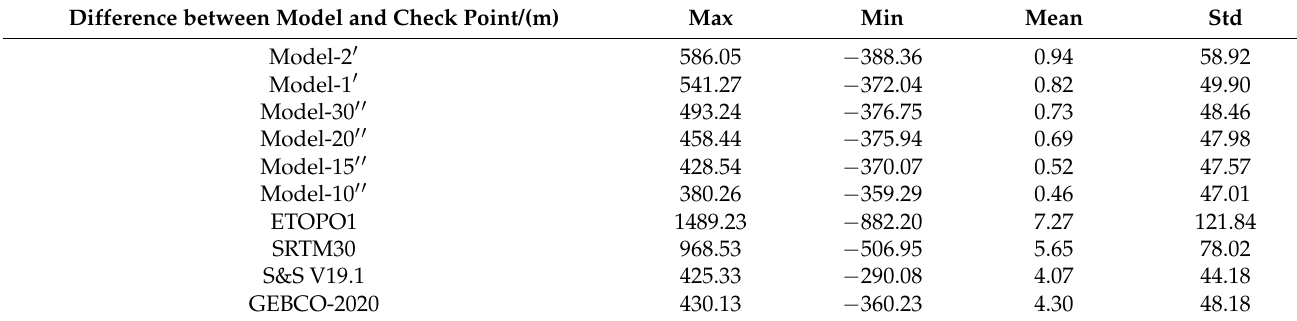
Table 3. Difference statistics of topographic model at check point (m).